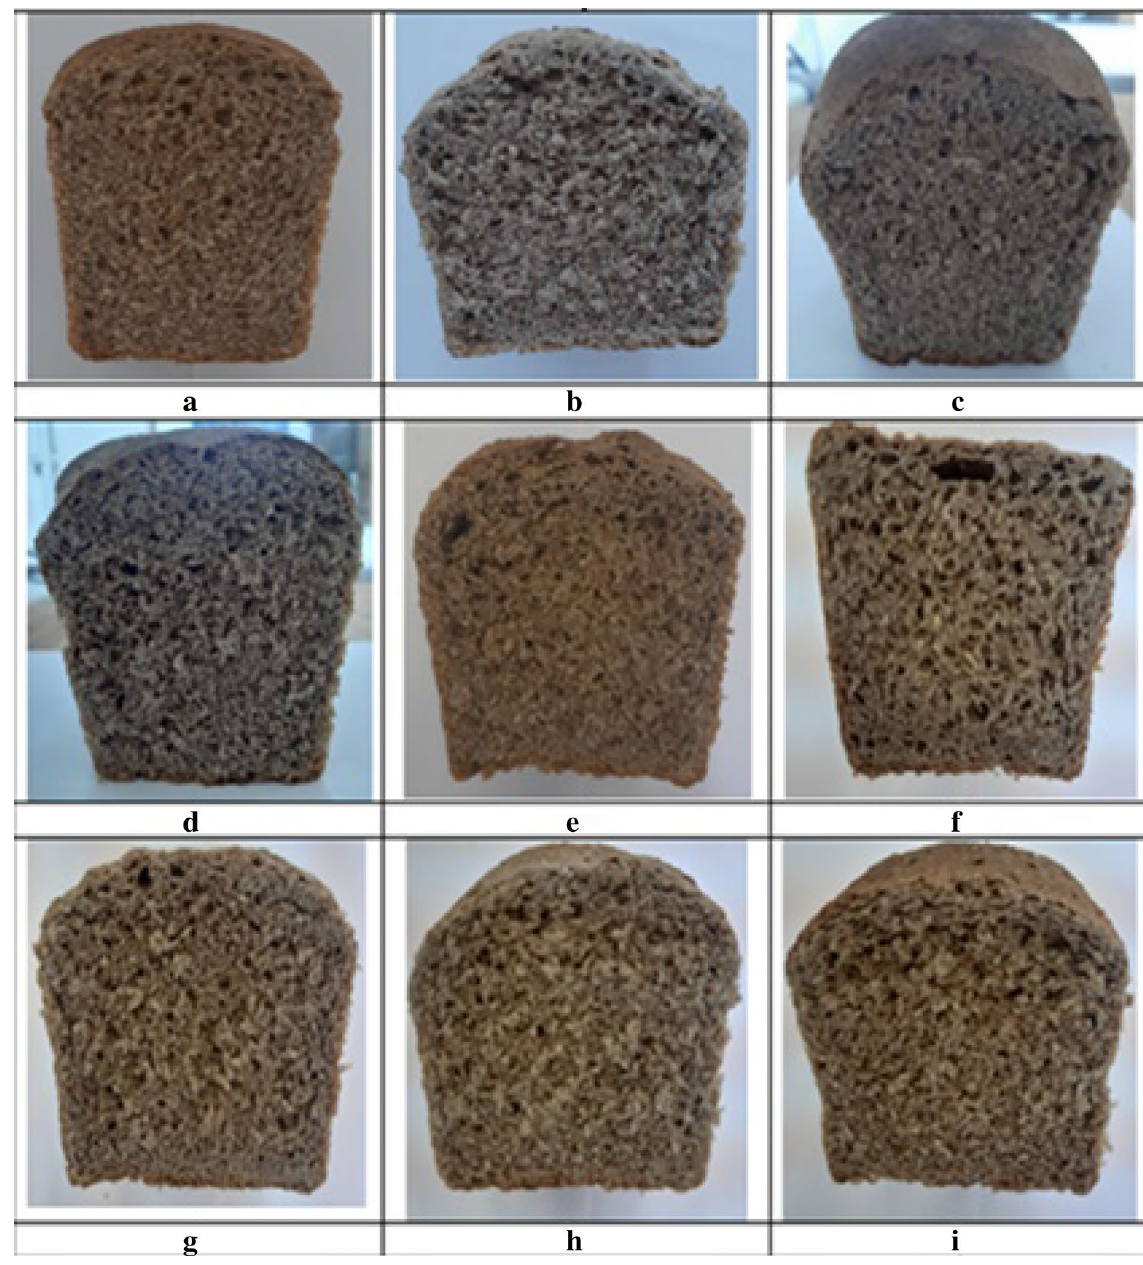
Figure 1. Photos of bread samples: ( a ) control sample, ( b ) sample 1, ( c ) sample 2, ( d ) sample 3, ( e ) sample 4, ( f ) sample 5, ( g ) sample 6, ( h ) sample 7, ( i ) sample